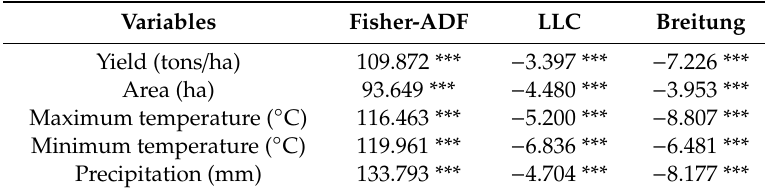
Table 4. Unit root test results.